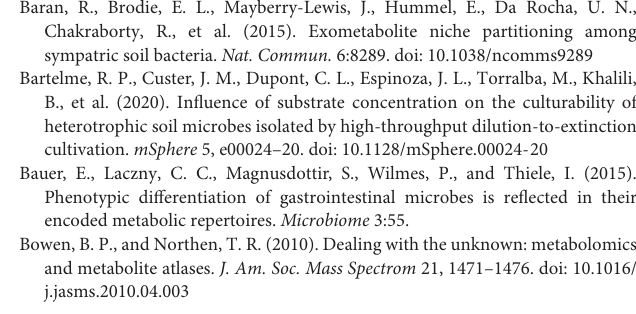
Supplementary Figure 1 | Phylogenetic tree of isolate sequences, guide sequences and reference sequences. The phylogenetic tree forms the basis for the phylogenetic tree in Figure 1 . Label colors indicate the phylogenetic origin of each sequence by class. REF and Guide indicates reference organism and were inserted for guidance and not used in this study. A complete list of the FASTA sequences can be found in Supplementary Information . Supplementary Figure 2 | Growth of isolates grown in R2A and NLDM. (A) Average ( n = 2 or n = 3) growth (as measured as the highest observed OD 600 minus starting OD 600 ) of each isolate grown on NLDM (in blue) and R2A (yellow). Black bars represent the average for each medium type. (B) Average ( n = 2 or n = 3) growth (as measured as the highest observed OD 600 minus starting OD 600 ) of each isolate grown on NLDM (in blue) and R2A (yellow) per phylogenetic class. ∗ Indicate that growth was significantly ( P < 0.05) higher in NLDM compared to R2A (pairwise t -test). Supplementary Figure 3 | Lag phase of isolates grown in R2A and NLDM. (A) Average ( n = 2 or n = 3) lag phase of each isolate grown on NLDM (in blue) and R2A (yellow). Black bars represent the average for each medium type. (B) Average ( n = 2 or n = 3) lag phase of each isolate grown on NLDM (in blue) and R2A (yellow) per phylogenetic class. ∗ Indicate that the lag phase was significantly ( P < 0.05) shorter in NLDM compared to R2A (pairwise t -test). Supplementary Figure 4 | Growth rates of isolates grown in R2A and NLDM. (A) Average ( n = 2 or n = 3) growth rate of each isolate grown on NLDM (in blue) and R2A (yellow). Black bars represent the average for each medium type. (B) Average ( n = 2 or n = 3) growth rates of each isolate grown on NLDM (in blue) and R2A (yellow) per phylogenetic class. Supplementary Figure 5 | Feature-based molecular networking. Identification of “produced” metabolites by comparing features observed in uninoculated medium vs. in isolate spent medium. Feature-based molecular networks with features detected in positive (A) and negative (B) polarity were colored to illustrate signals coming from metabolites produced by the isolates in this study. Features observed in less than 16% of NLDM uninoculated controls were colored from dark to light based on the ratio (0.01–1) of the number of samples of isolate spent medium the feature was observed in divided by the total number of isolate spent medium samples, with a ratio of 1 indicating that the feature was observed in all isolate spent medium